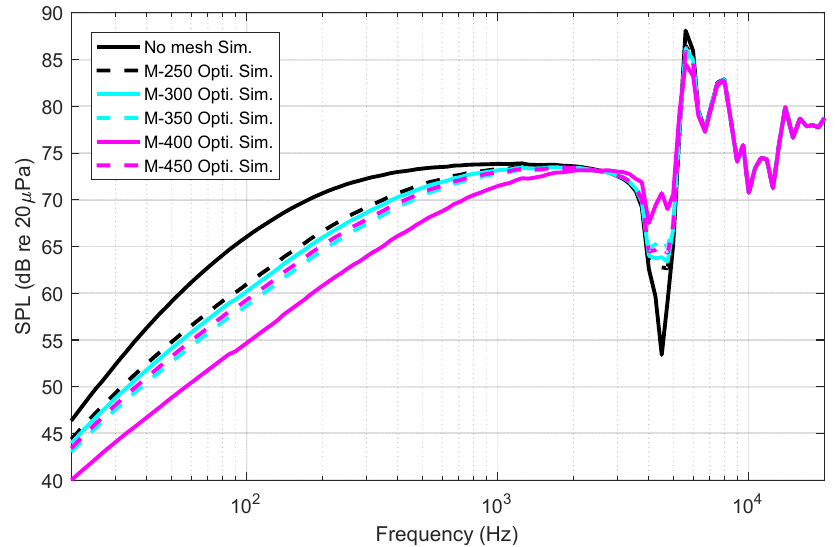
Figure 9. Simulated frequency responses of microspeaker without and with meshed ventilation cloths (M-250 to M-450).